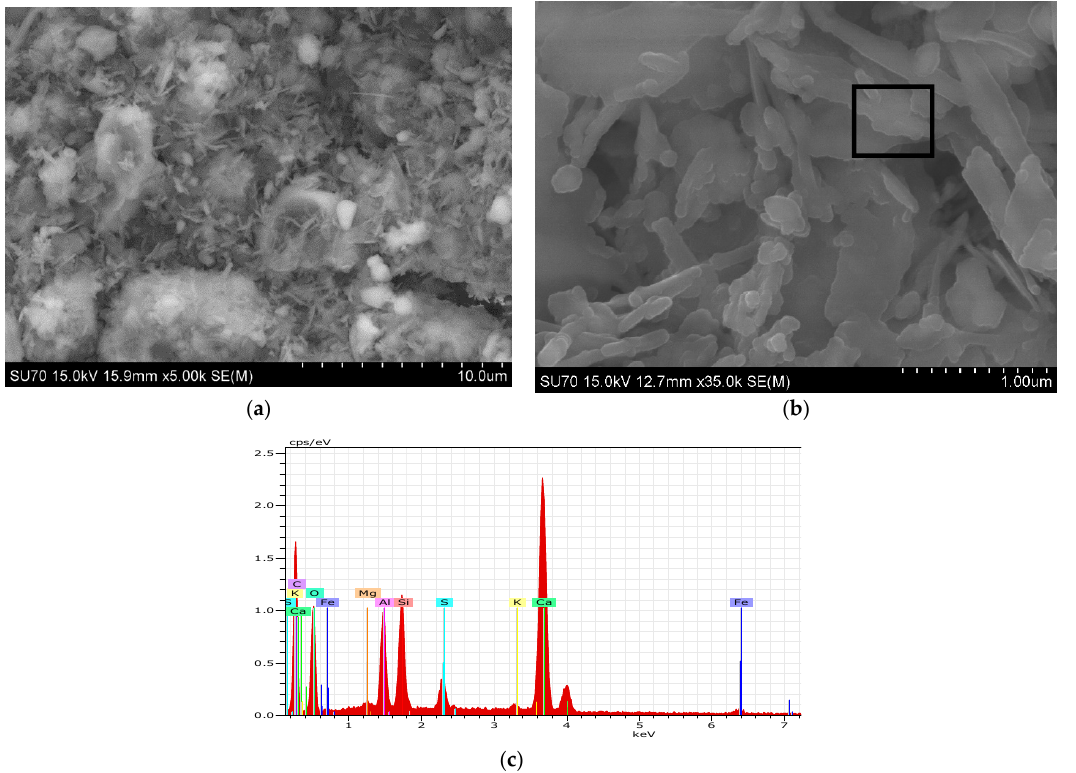
Figure 5. ( a – c ) SEM micrograph of 3_NCPV, ( d ) EDS spectrum of the needle ‐ shaped particles.